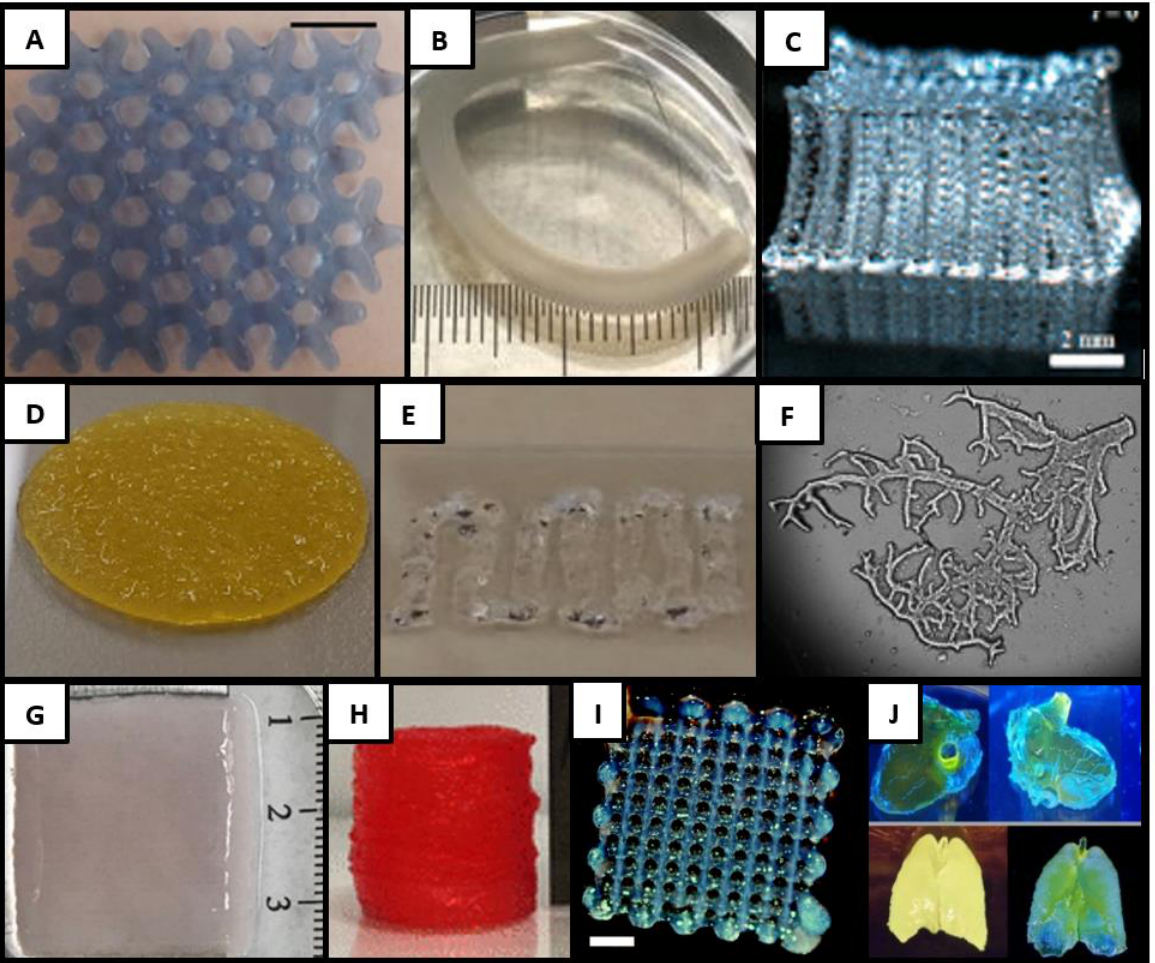
Figure 2. Examples of biologically based bioinks. ( A ) An agarose alginate blend printed for cartilage development [17]. ( B ) Alginate extruded through a triaxial nozzle for blood vessel replacement [32]. ( C ) A large multilayered chitosan construct showing mechanical integrity of printed chitosan processed in an acidic environment [56]. ( D ) Collagen printed over a PCL scaffold (28 mm diameter) for use as a heart valve replacement [65]. ( E ) A combination of ECM and hyaluronic acid gel was seeded with liver spheroids [66]. ( F ) DLP printing of branched ECM [67]. ( G ) A multilayer fibrin skin construct [68]. ( H ) Examples of multilayer gelatin constructs developed for use with osteoblasts [69]. ( I ) Hyaluronic acid extruded with chondrocytes for cartilage engineering [70]. ( J ) Complex structures printed using a DLP printer and silk fibroin ink [71].